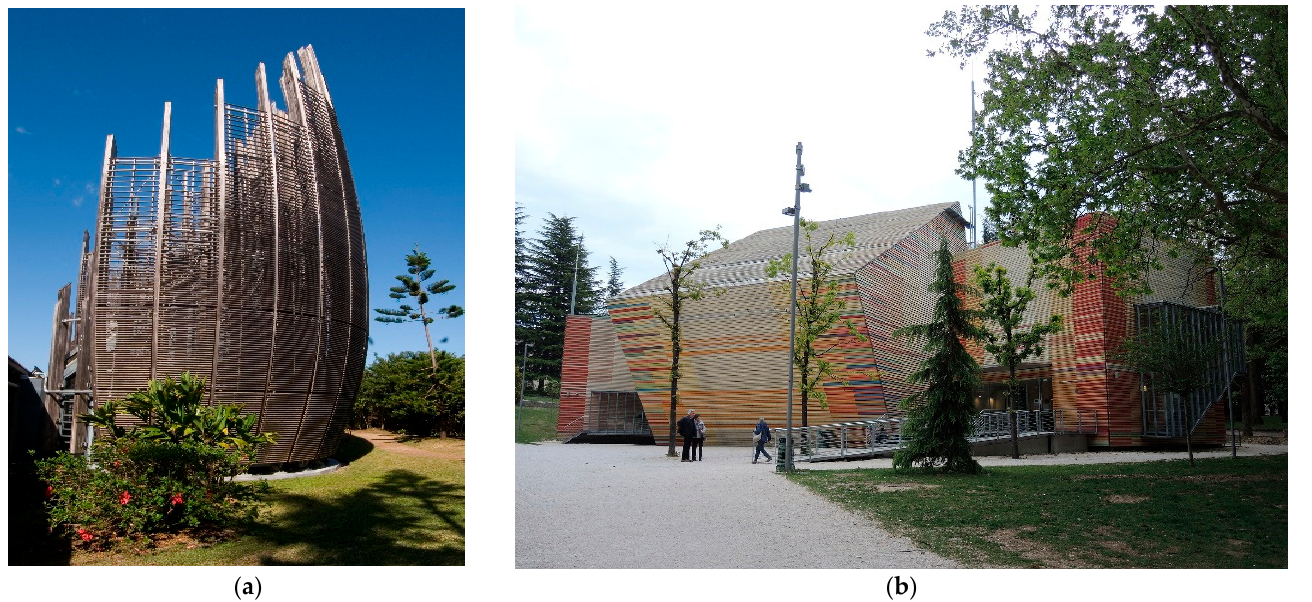
Figure 5. ( a ) Jean-Marie Tjibaou Cultural Centre in New Caledonia 1998; architect: Renzo Piano; source: Wikimedia Commons; ( b ) Auditorium in l’Aquila ; architect: Renzo Piano; source: Wikimedia Commons.